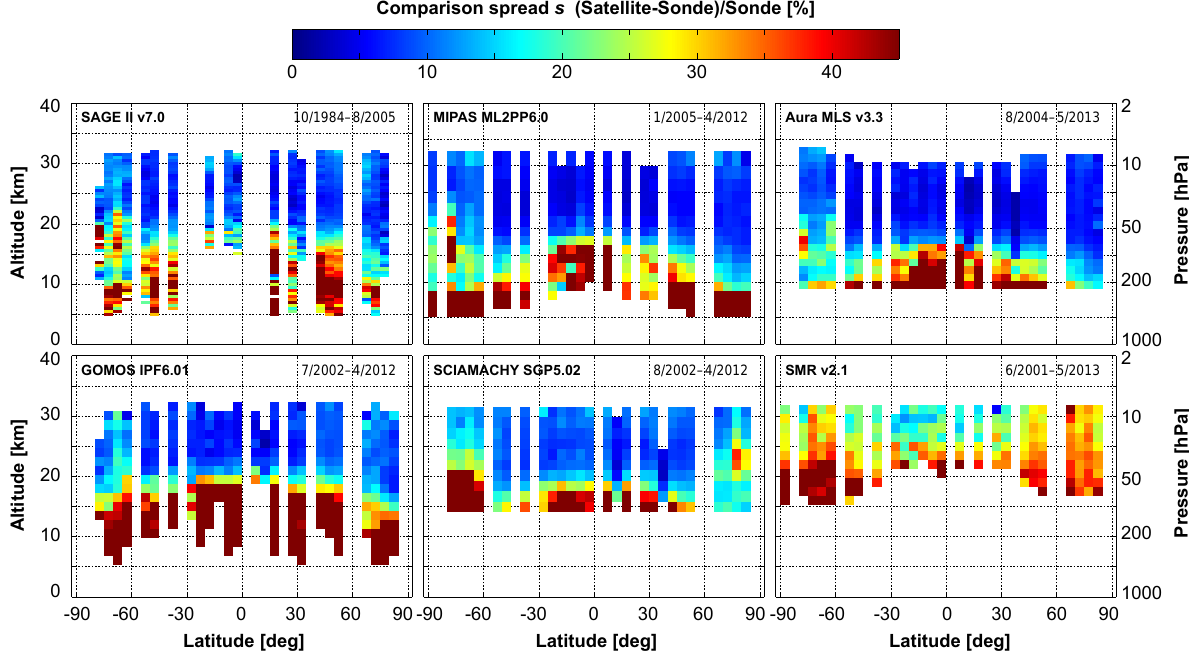
Figure 7. Meridional structure of the comparison spread s of six satellite records relative to the ozonesonde network. The analysis is performed in the native profile representation of each satellite record. Only bins with more than five comparison pairs are